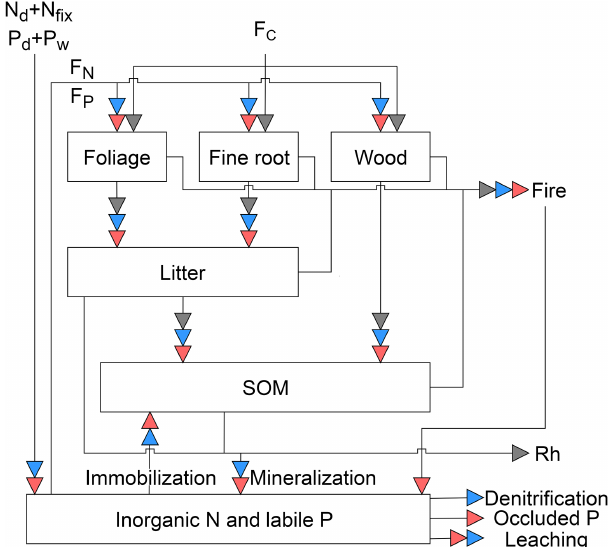
Figure 1. Schematic representation of the pools and fluxes in the C, N, and P cycles within GOLUM-CNP. The gray, blue, and red arrows represent C, N, and P fluxes, respectively. Plants are divided into foliar, fine root, and wood pools, where the wood pool includes woody stems and coarse roots. Litter and soil are two separate pools. The inorganic pool represents the nutrient sources in the soil that are available for plant uptake. Arrows between the pools represent the directions of C, N, and P flow between pools. External inputs of N are atmospheric deposition ( N d ) and biological N fixation ( N fix ). External inputs of P are atmospheric deposition ( P d ) and P released by rock weathering ( P w ). F C is net primary production (NPP). F N and F P are plant uptake of N and P from the inorganic N and labile P pools, respectively. R h is release of C due to heterotrophic respi- ration. Mineralization of N and P is modeled along with litter and SOM decomposition, and N and P immobilization is modeled by a flux from the inorganic pool to SOM. External losses of N occur by fire, leaching, and denitrification. External losses of P occur by fire, leaching, and transfer to occluded P in the